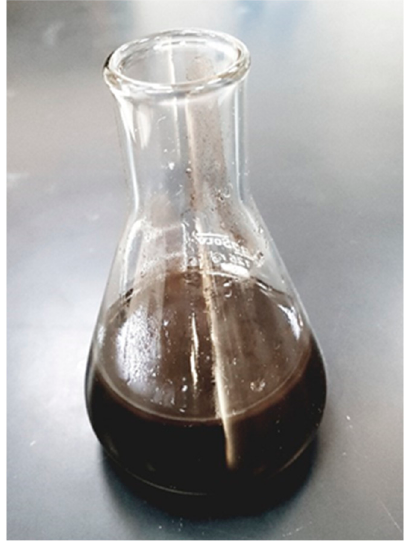
Figure 8. The Fe black oxide that formed in the solar-heated water in Fe containers. It can be observed from Figure 9 that high water temperatures can be attained in the range of 87–89 °C, even in the cold winter, with approximately a 14 °C mean value of T wat. and low global solar intensity of approximately 293 W/m 2 during the measurement duration.